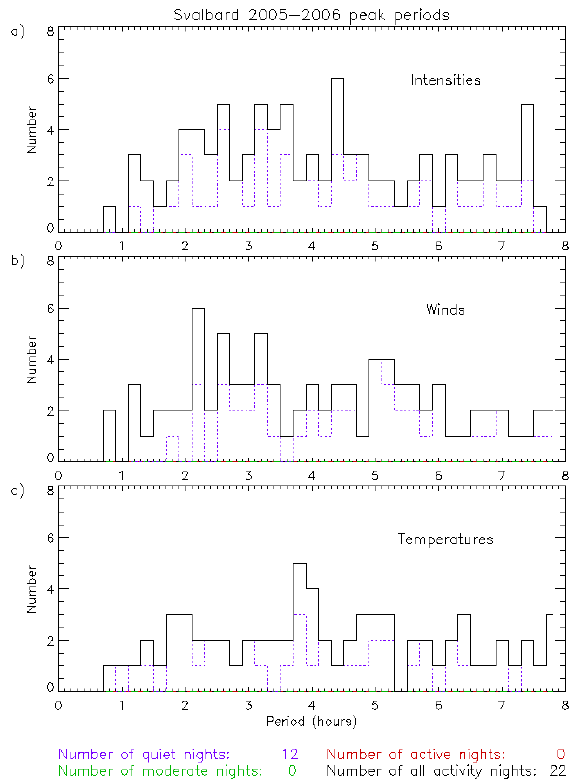
Fig. 10. Histogram of gravity wave periods for all nights and all activity levels, from Svalbard data over the winter season of 2005– 2006: (a) intensities, (b) winds, and (c)